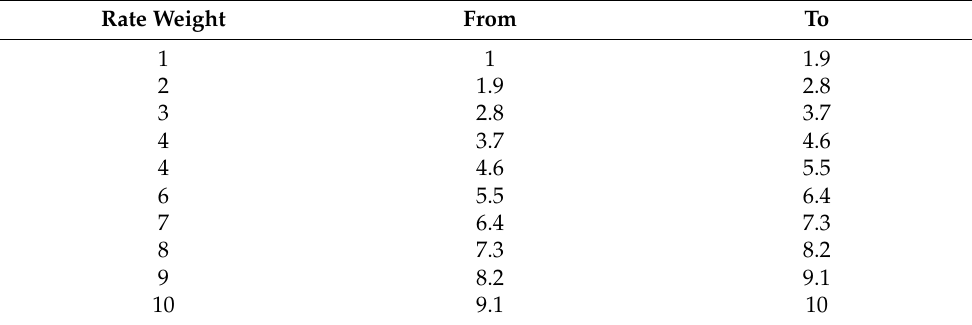
Table 4. Level of anxiety of participants ( n = 87).